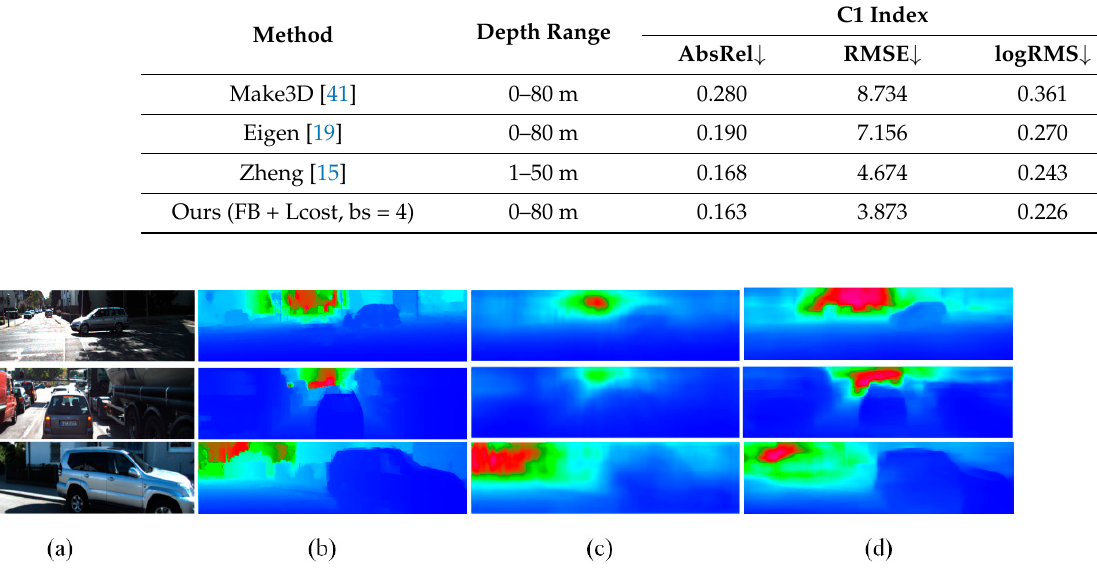
Table 3. Error comparison of different methods on the KITTI dataset.